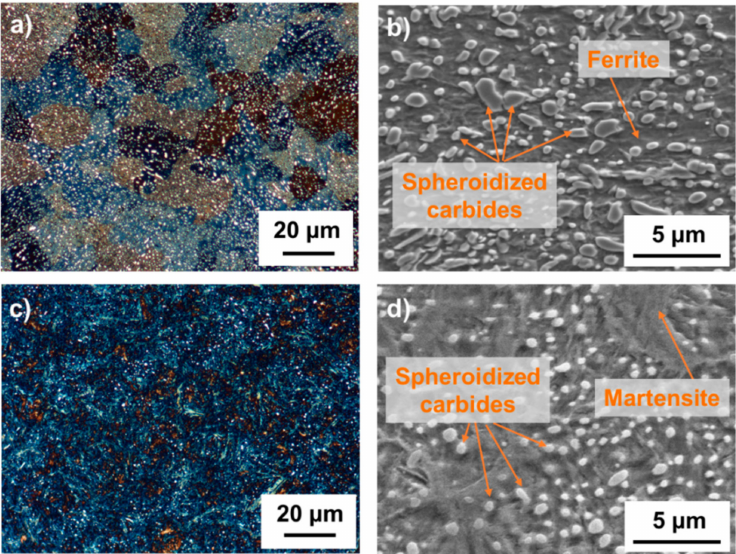
Figure 2. Metallography and microstructure of 100Cr6 bearing steel under different conditions: ( a ) LOM; ferritic matrix with spheroidized carbides after spheroidization at 800 ◦ C for 7200 s; ( b ) SEM; ferritic matrix with spheroidized carbides at 800 ◦ C for 7200 s; ( c ) LOM; martensitic matrix with partially dissolved spheroidized carbides after austenitization at 850 ◦ C for 300 s and the subsequent quenching in Ar; and ( d ) SEM; martensitic matrix with partially dissolved spheroidized carbides at 850 ◦ C for 300 s and the subsequent quenching in